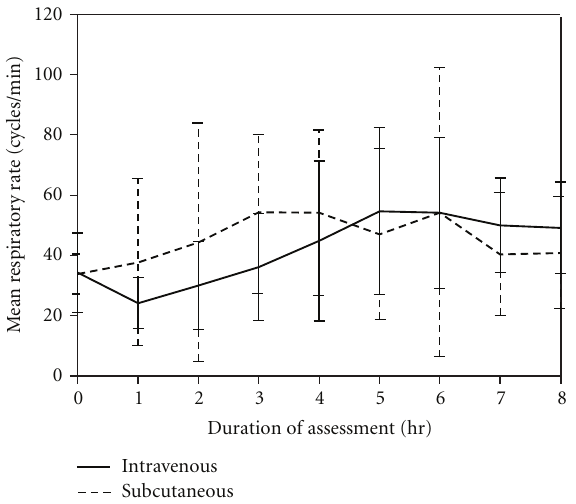
Figure 2: Mean rectal temperatures over time for the IV and SC groups (IV group, P = 0 . 082; SC group, P = 0 . 331).